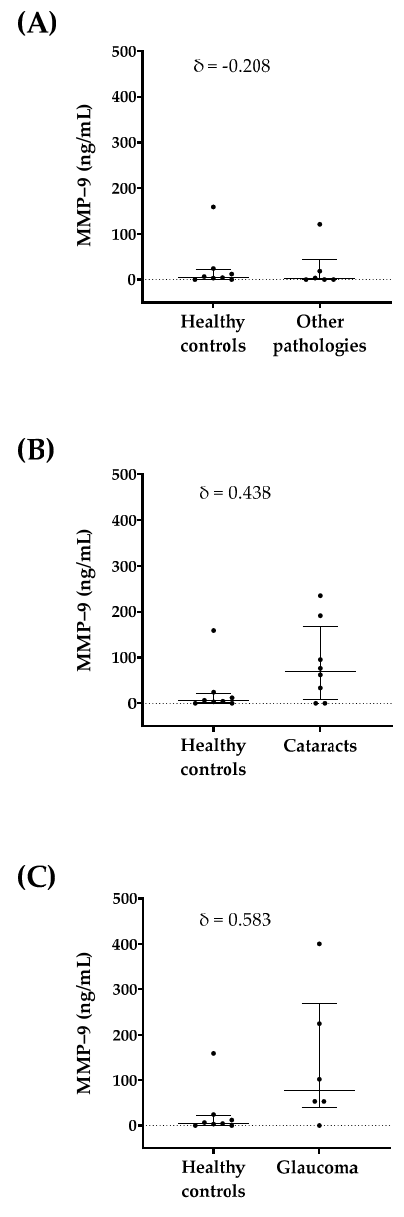
Figure 4. Tear MMP-9 concentration differences in the groups of patients suffering ocular inflammation versus the group of healthy controls. Cliff’s delta values are displayed for each comparison. ( A ) Differences between healthy controls and MGD, DE, and allergy patients (other pathologies group). ( B ) Differences between healthy controls and cataracts patients. ( C ) Differences between healthy controls and glaucoma patients.